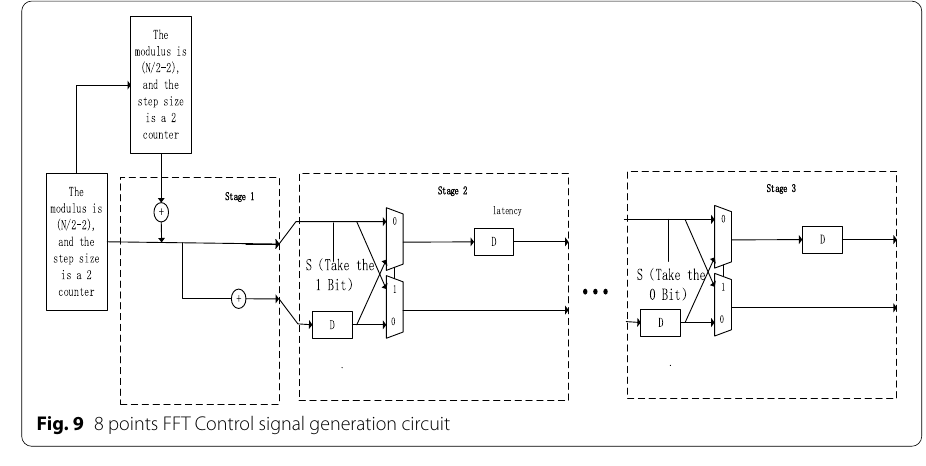
Fig. 9 8 points FFT Control signal generation circuit